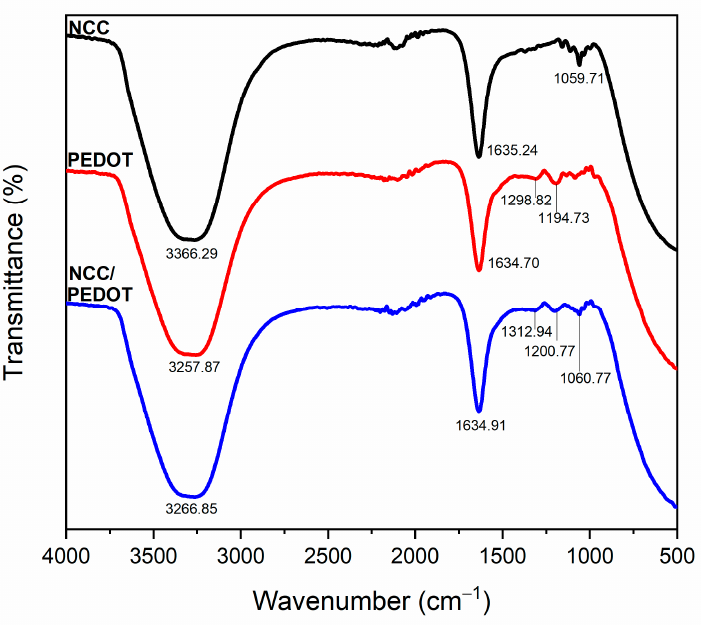
Figure 2. FTIR spectrum of NCC, PEDOT, and NCC/PEDOT thin film.